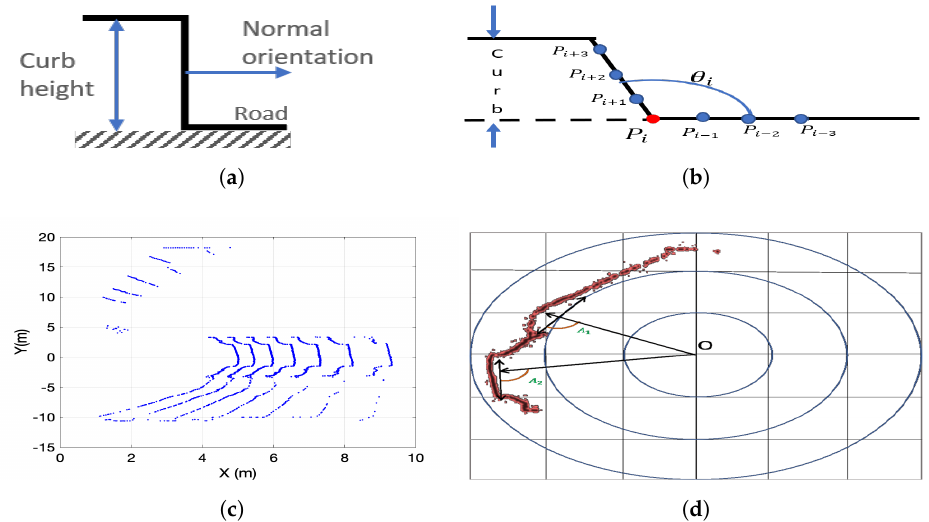
Figure 13. Road curb geometric features: ( a ) Curb height step and normal orientation. ( b ) Slope angle formed by the road surface and the curb. ( c ) LiDAR 3D conic section compression. ( d ) Tangential